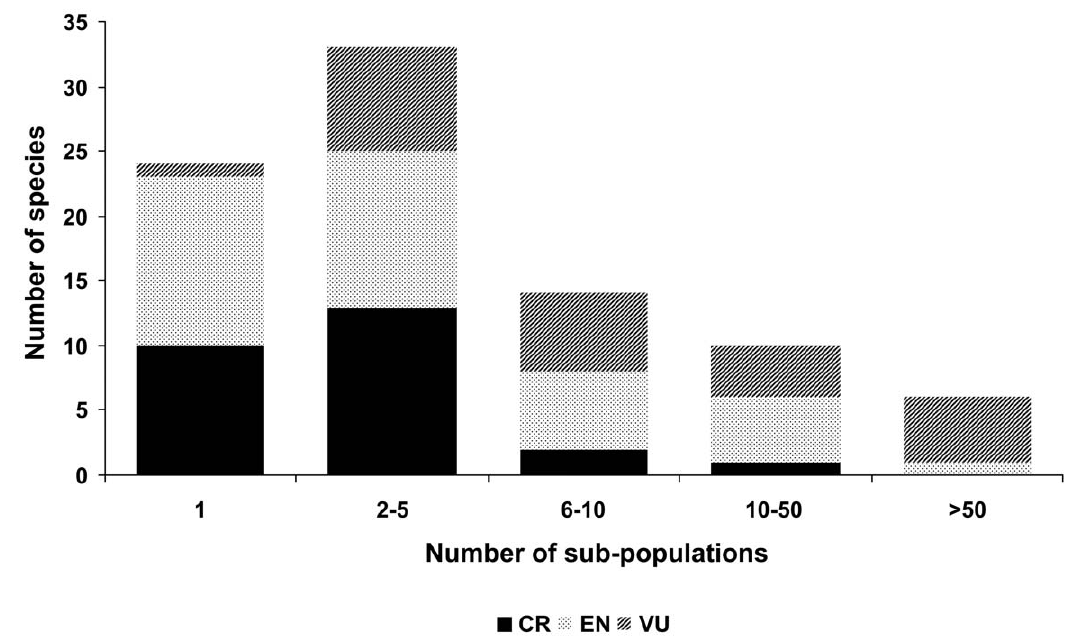
Figure 4. Numbers of extant subpopulations for species with known T.